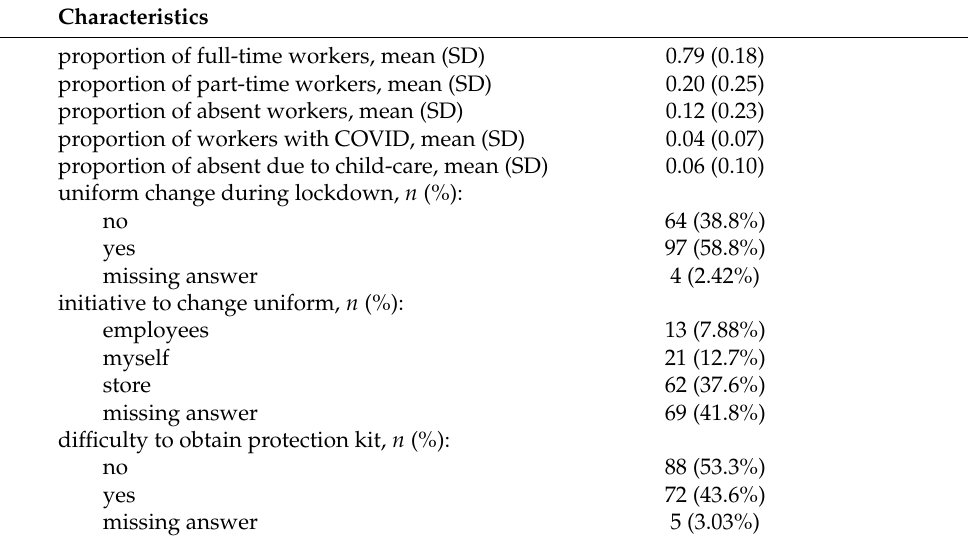
Table 4. Description of employees’ conditions reported by supervisors ( n = 165, the responses with irrelevant information concerning the number of employees were removed from